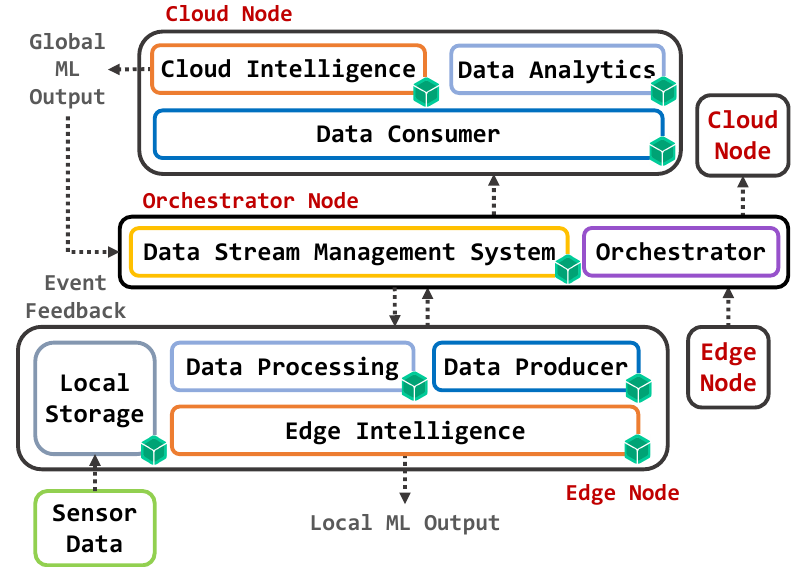
Figure 1. Reference